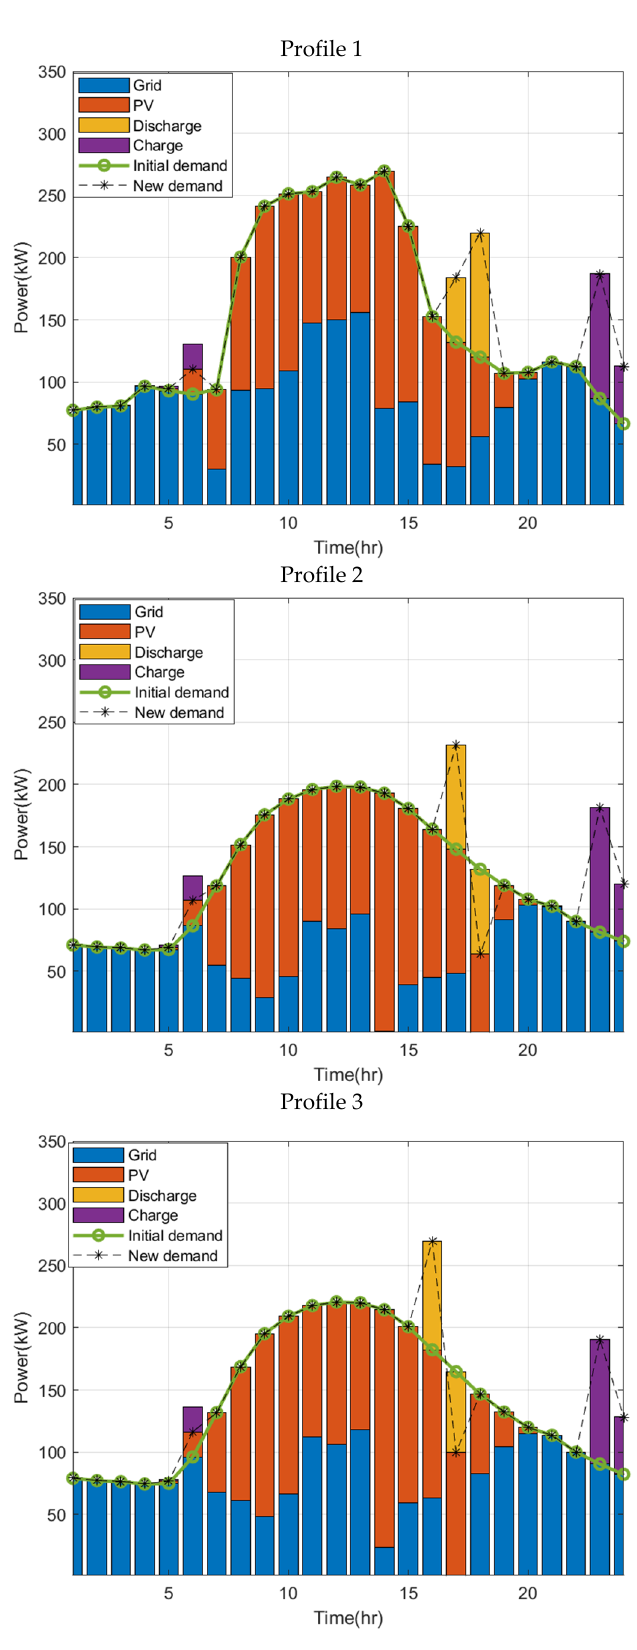
Figure 12. Operation of ESS in July. Profile 1—Using real smart meter data (Section 4.1.1); Profile 2—Using energy bills, standard profiles, and measurement for validation (Section 4.1.2); Profile 3—Using short-term measurement, standard profile, and contracted power (Section 4.1.3).